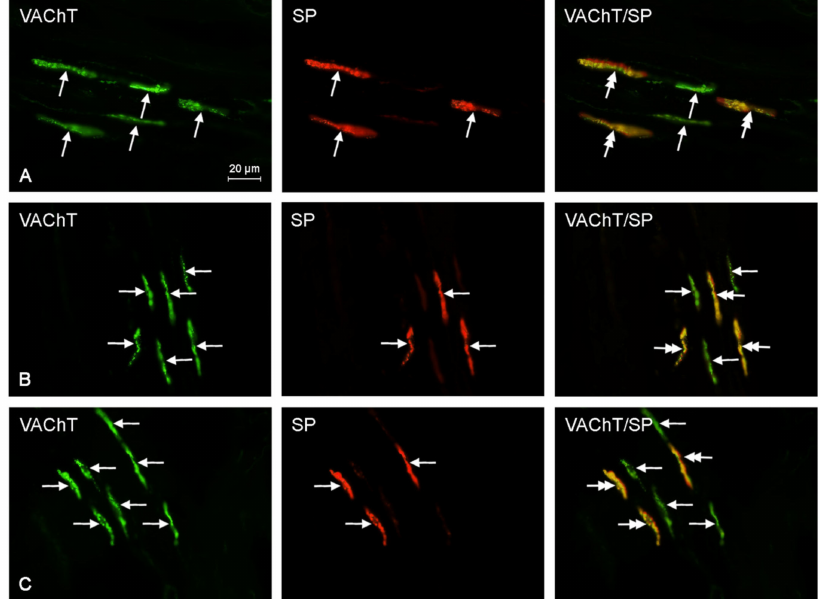
Figure 3. Representative images of immunocytochemical localization of VAChT- and SP-immunoreactive nerve fibers in intrahepatic sympathetic nerves (arrows) of the control (CTRL; ( A )), E1—experimental group 1 (low dose of bisphenol A; ( B )), and E2—experimental group 2 (high dose of bisphenol A, ( C )); VAChT or SP-IR nerve fibers are indicated with arrows, VAChT and SP-IR nerve fibers are indicated with double-headed arrows; scale bars in all figures; 20 µ